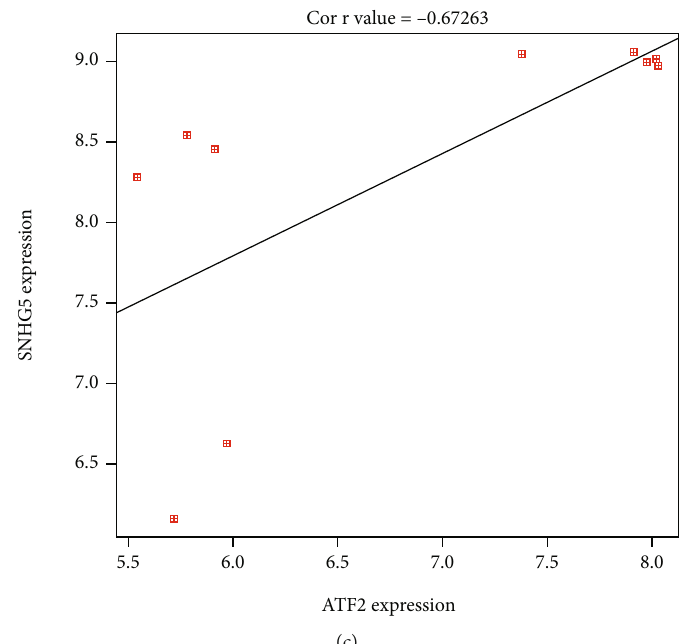
Figure 8: Correlation analysis results of genes. (a) Negative correlation between SNHG5 and miR-299-5p. (b) Negative correlation between ATF2 and miR-299-5p. (c) Positive correlation between SNHG5 and